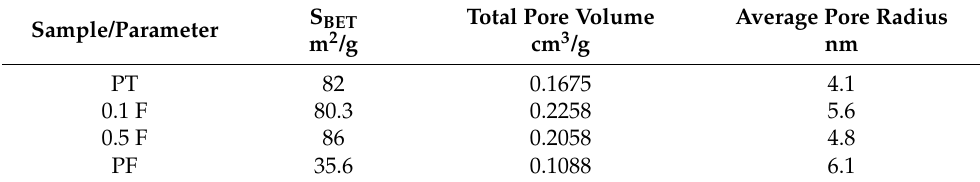
Table 3. N 2 -Physorption analysis